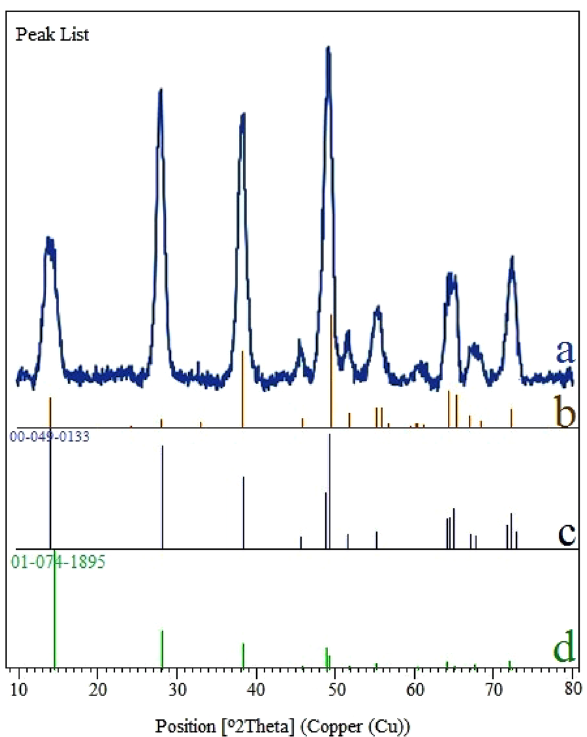
Figure 7. Original XRD pattern of boehmite NPs ( a ), Observed peaks list from normal XRD pattern of boehmite NPs ( b ), standard pattern code 00-049-0133 of boehmite NPs ( c ), and standard pattern code 01-074- 1895 of boehmite NPs ( d ).